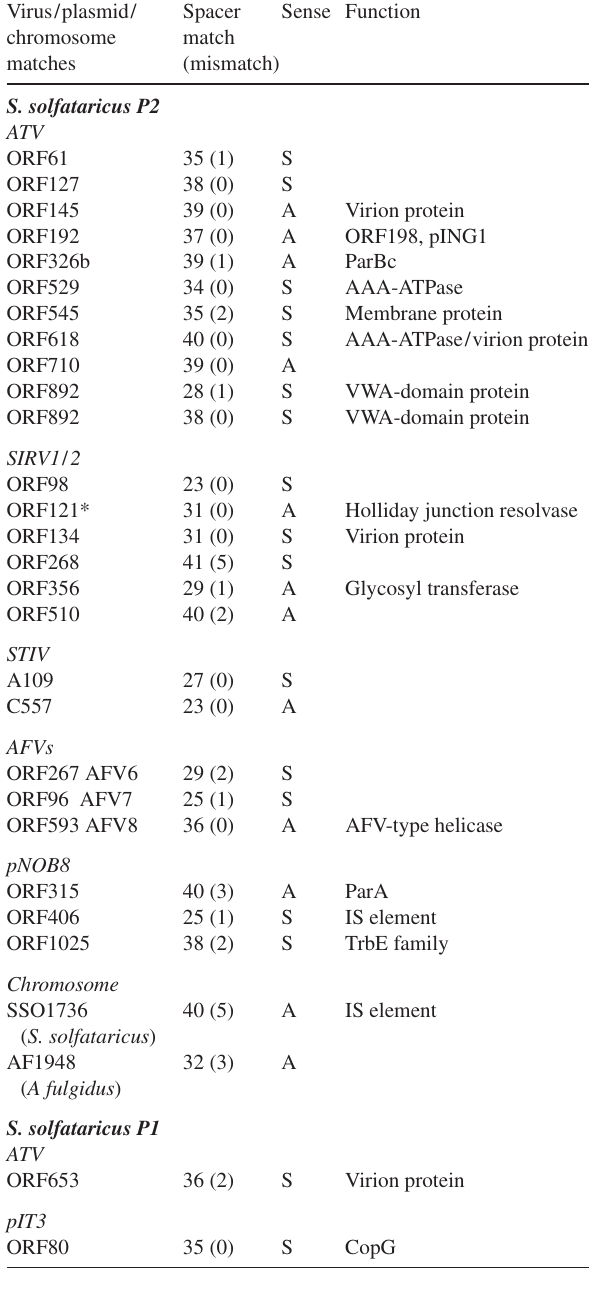
Table 7. Spacer sequence matches between S. solfataricus strains P2 and P1 and viruses, plasmids and chromosomes. Matches of ATV and pIT3 to strain P1 are additional to those found for strain P2B, as illus- trated in Figure 1. Symbol: * = an exclusive match to SIRV2. Litera- ture references to the viral and plasmid sequences are given in the text for strain P2, and see Prato et al. 2006 regarding the pIT3